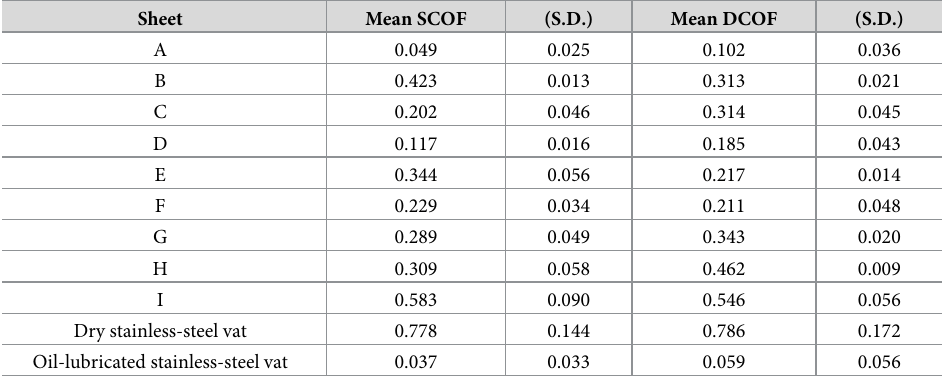
Table 1. Mean SCOFs and DCOFs between test sheets and test shoe found in mechanical friction tests. Sheet Mean SCOF